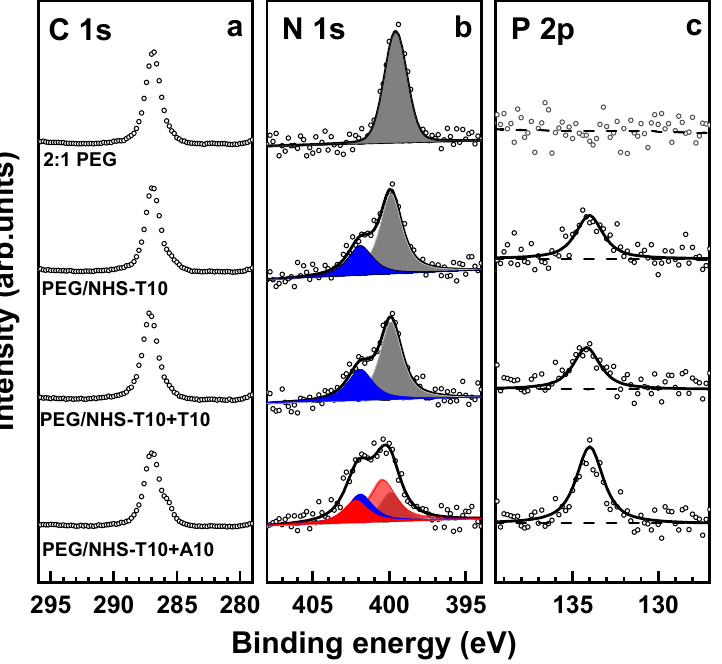
Figure 5. C 1s (a), N 1s (b), and P 2p (c) XP spectra of the original 2:1 PEG film, PEG film exposed to NHS-T10 (PEG/NHS-T10), and PEG/NHS-T10 probe film exposed to mismatching (T10) and matching (A10) target ssDNA. The N 1s spectra are decomposed into individual contributions related to the amine groups in the PEG matrix (dark gray), thymine (blue), and adenine (red). The P 2p spectra are tentatively fitted by a single peak (solid lines) and a linear background (dashed lines).